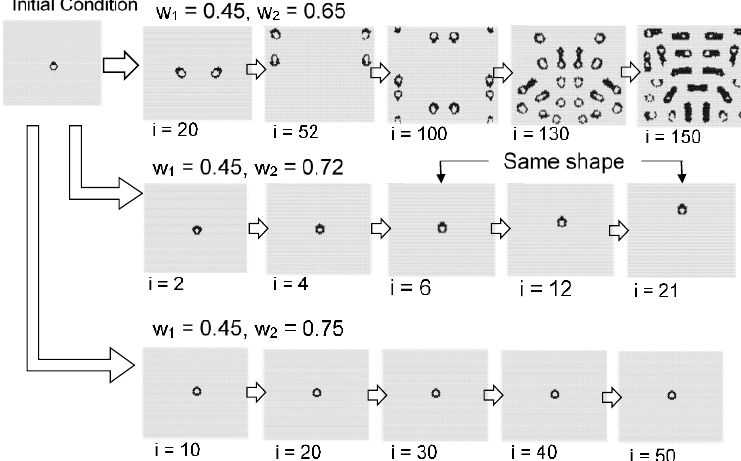
Figure 17. Results for the model with s = 5 and t = 8 in a hexagonal grid. The initial pattern was a symmetrical ring. When w 1 = 0.45 and w 2 = 0.48, the ring pattern disappeared. When w 1 = 0.45 and w 2 = 0.55, the ring pattern spread while breaking apart. When w 1 = 0.45 and w 2 = 0.60, still patterns were formed.